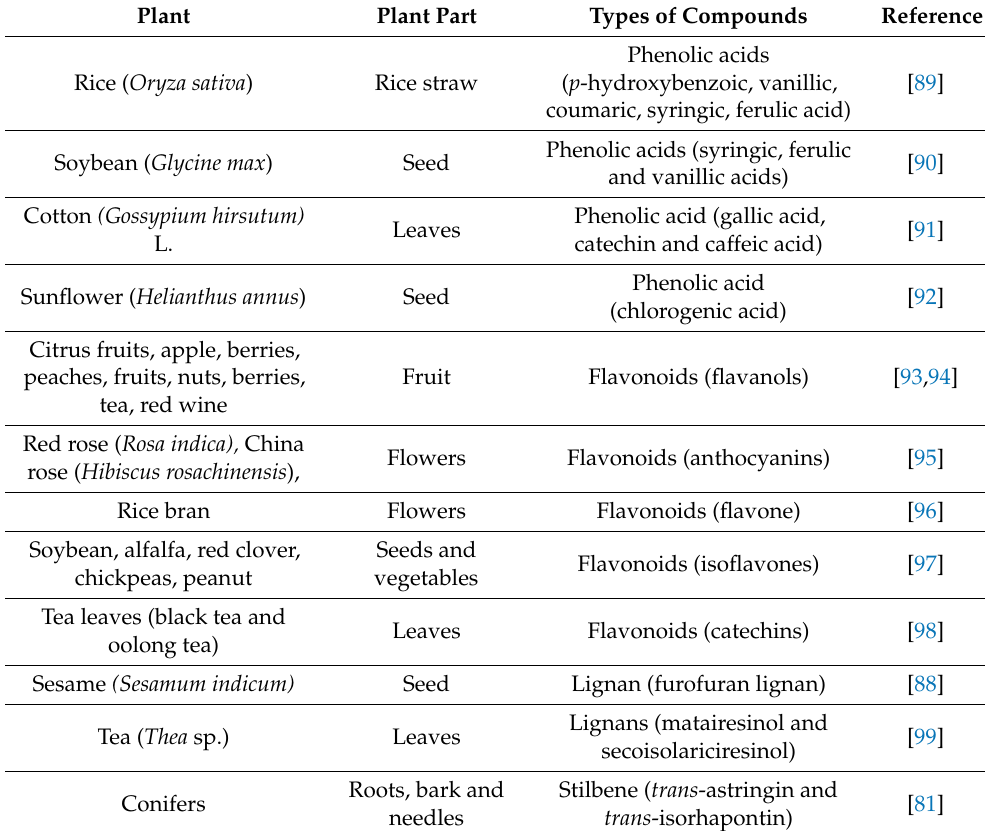
Table 2. Main classes of polyphenols and their localization in different plant parts. Plant Types of